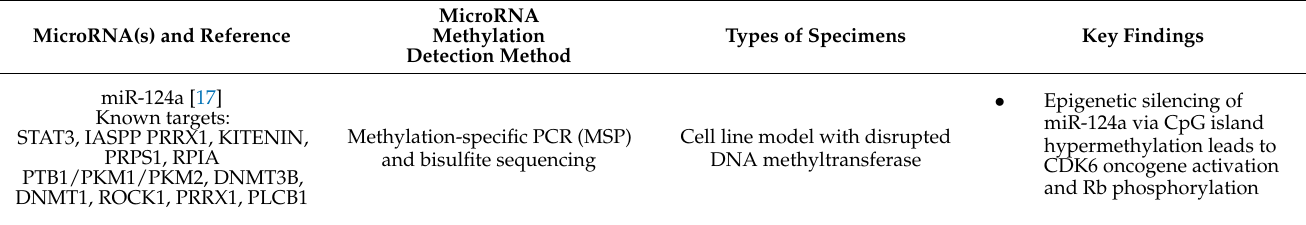
Table 1. Snapshot of methylation-sensitive microRNAs implicated in